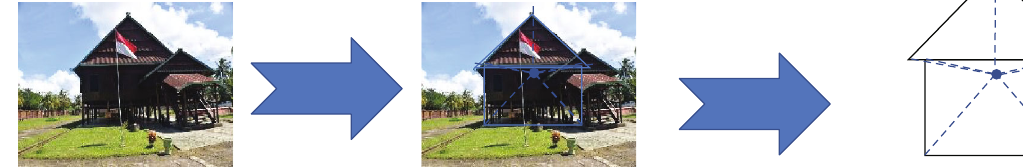
Figure 46: The construction of building number ̂ 4